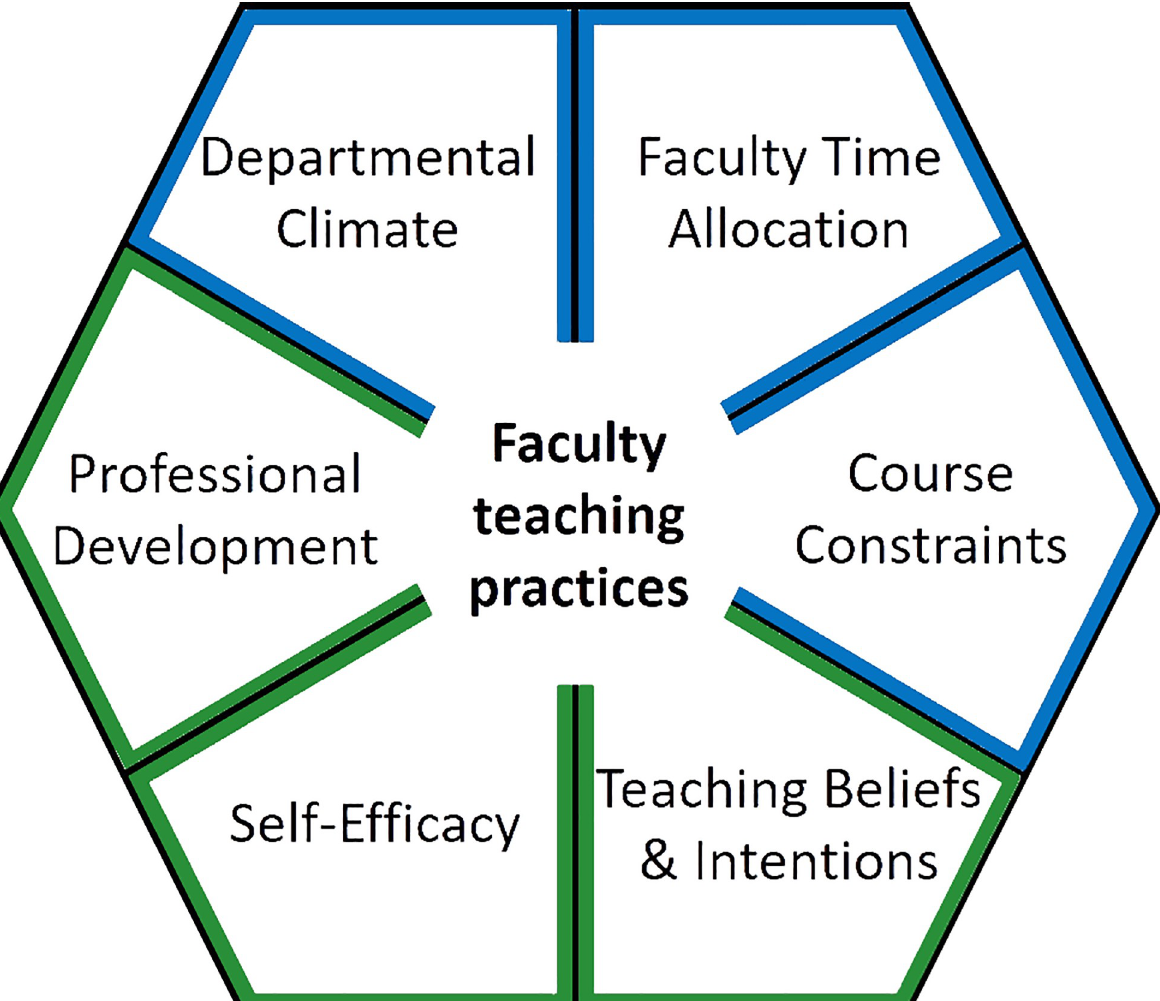
Fig 1. A model of faculty teaching practices as affected by individual characteristics (green) and environmental influences (blue). Specific metrics or subscales used in the multivariate model of learner-centered teaching practices included participation in the FIRST IV program (Professional Development), Self-efficacy in teaching (Self-Efficacy), and Intentions with regards to knowledge transmission (Teaching Beliefs & Intentions), Support for teaching (Departmental Climate), Percent time spent teaching (Faculty Time Allocation), and Course size (Course